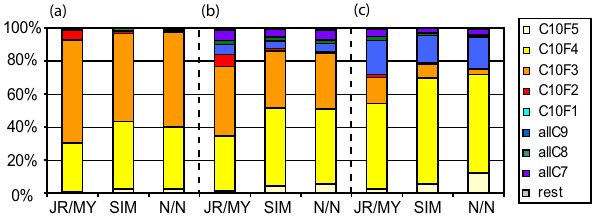
Fig. 9. Simulated distribution of the gaseous and condensed sec- ondary organics as a function of the type of functionality at the end of the (a) low-, (b) intermediate- and (c) high-NO x